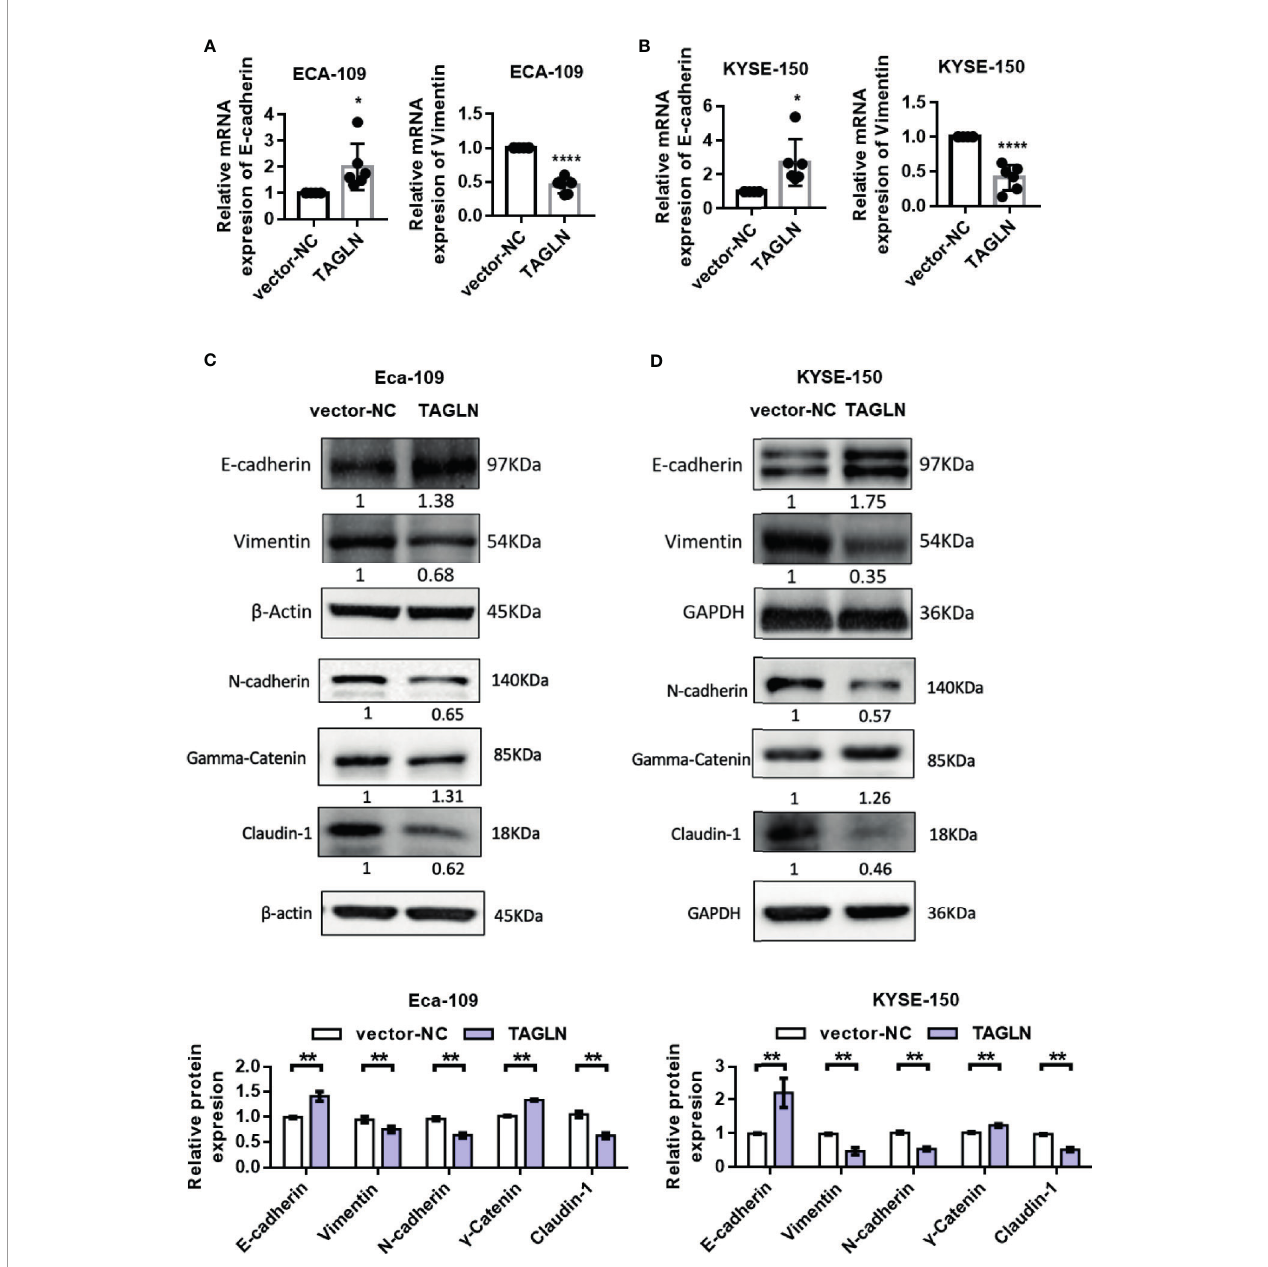
FIGURE 3 | Effects of overexpression of Transgelin on E-cadherin and Vimentin expression in Eca-109 and KYSE-150 cells. (A) The expression levels of E-cadherin and Vimentin in Eca-109 cells after Transgelin overexpression were detected by qRT-PCR. (B) The expression levels of E-cadherin and Vimentin in KYSE-150 cells after Transgelin overexpression were detected by qRT-PCR. (C) The expression levels of E-cadherin, Claudin-1, N-cadherin, g -Catenin and Vimentin in Eca-109 cells after Transgelin overexpression were detected by western blot. (D) The expression levels of E-cadherin, Claudin-1, N-cadherin, g -Catenin and Vimentin in KYSE-150 cells after Transgelin overexpression were detected by western blot. The data are presented as the mean ± SEM of three independent experiments. * P < 0.05, ** P < 0.01, and **** P < 0.0001 by two-tailed Student ’ s